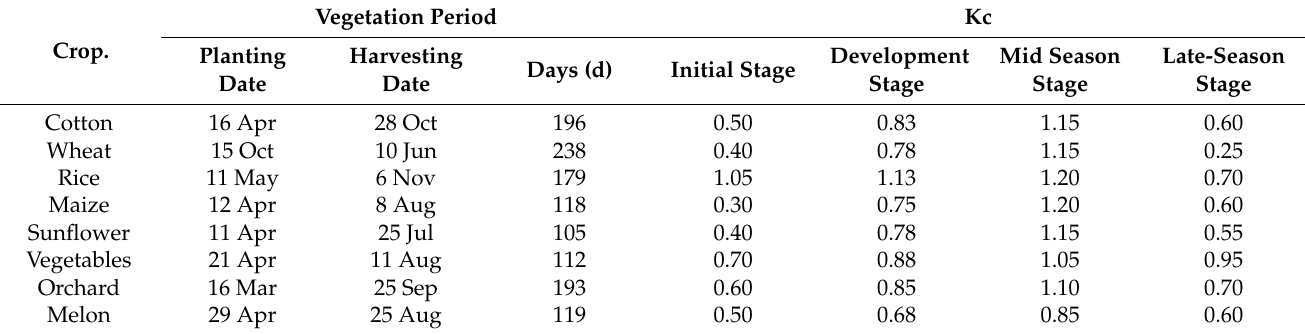
Table 2. Crop seasonal information in the study